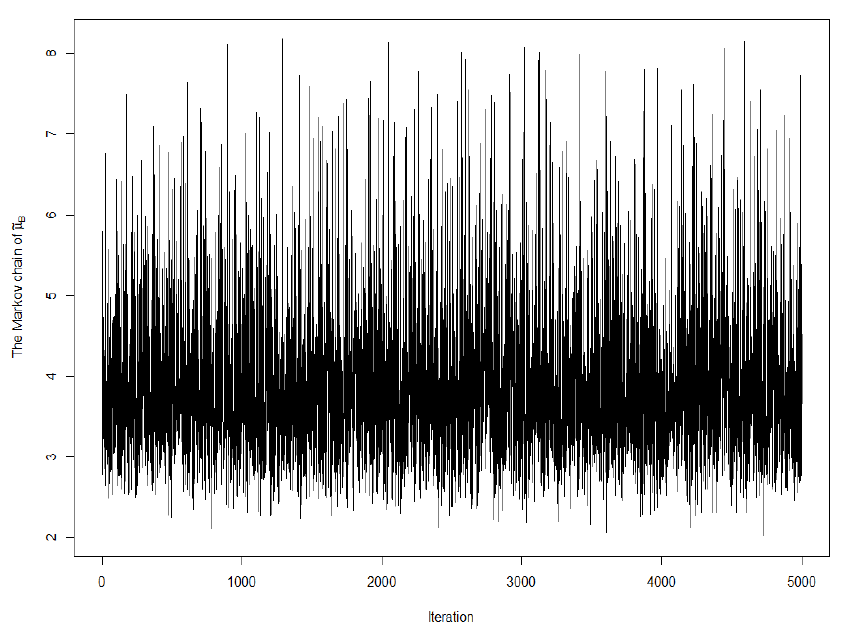
Figure A1. The Markov chain with 5000 iterations of ˜ µ BE after